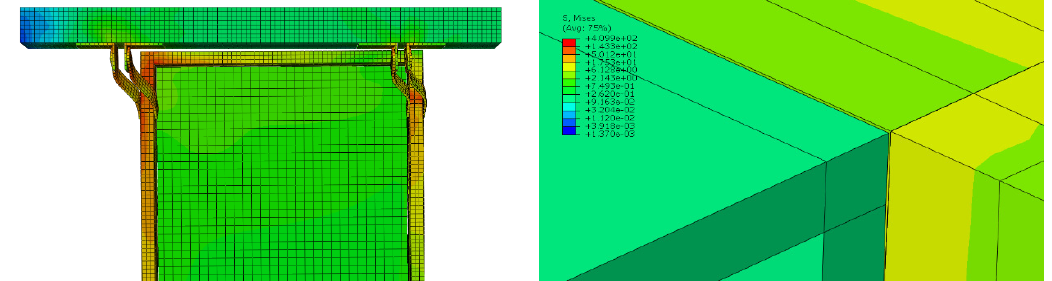
Figure 35. Relationship of linear guide length to maximum stress applied to the curtain wall.